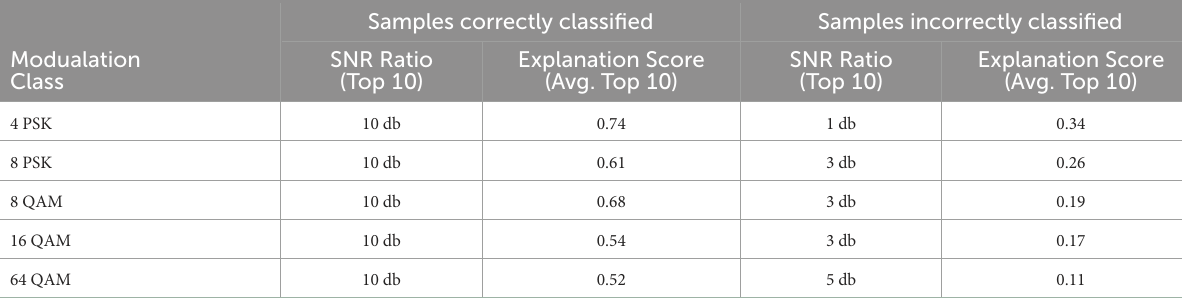
TABLE 2 The error analysis and reasoning via explainability measurable metric